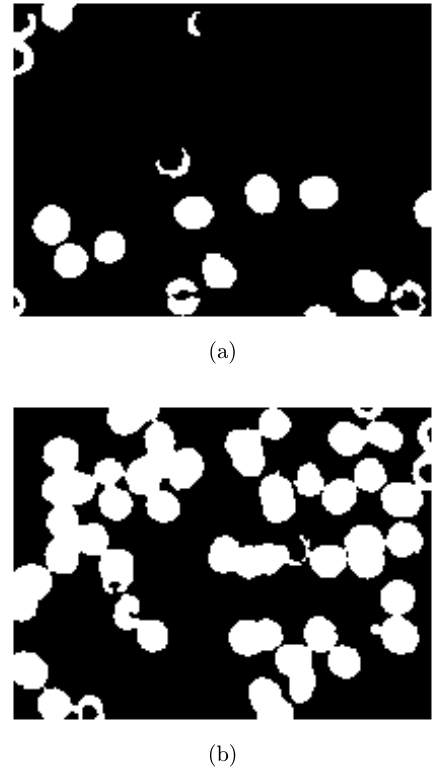
Fig. 5. Classi¯cation of erythrocyte (a) individual ones and (b) overlapping erythrocytes